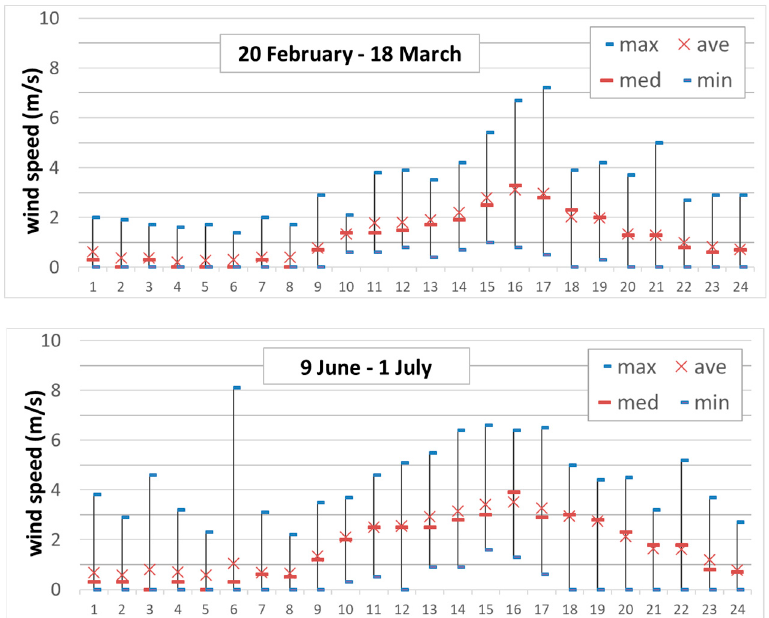
Figure 7. The diurnal wind speed ranges, averages and medians for Subang averaged over the wet and dry periods focused in this study (data from MetMalaysia).